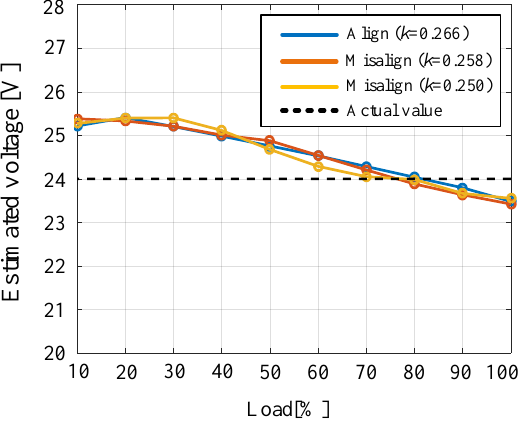
Figure 8. The estimated value of the output voltage according to load and alignment condition.